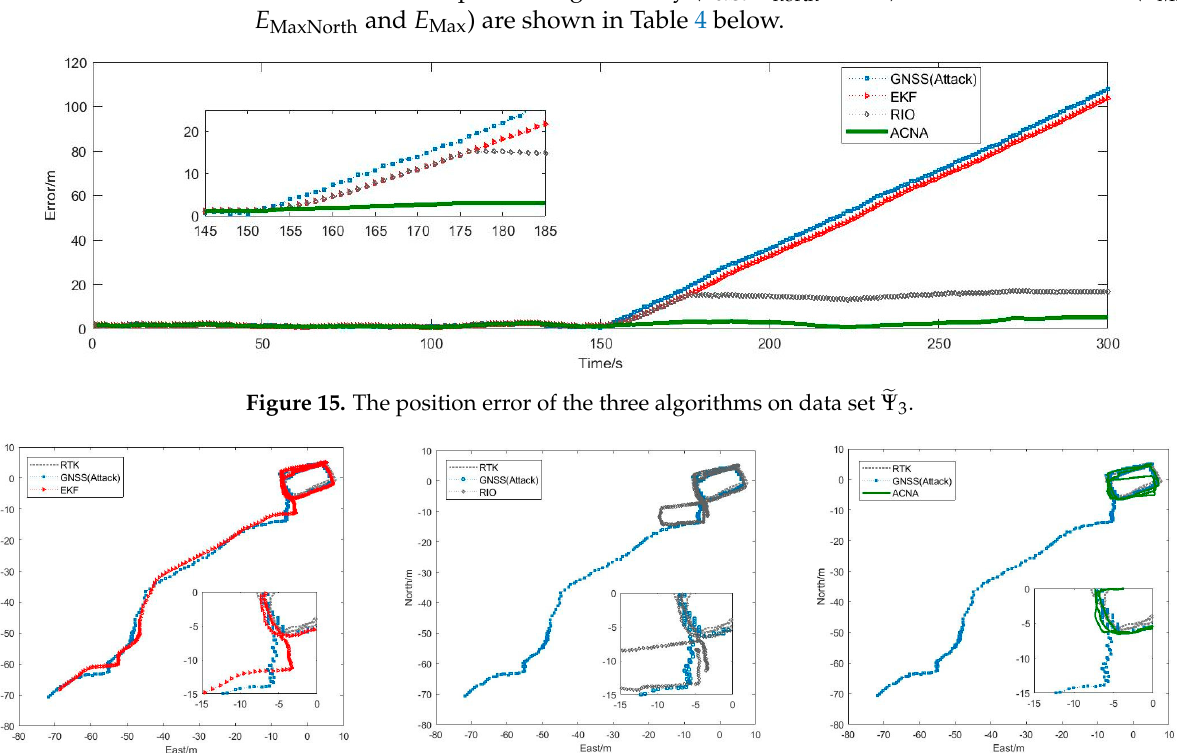
( c ) Figure 14. The trajectories of the three algorithms on data set 2 Ψ  : ( a ) EKF; ( b ) RIO; ( c ) ACNA. Table 3. East, north and relative positioning accuracy and maximum error of the three algorithms on data set 2 Ψ  . Algorithm